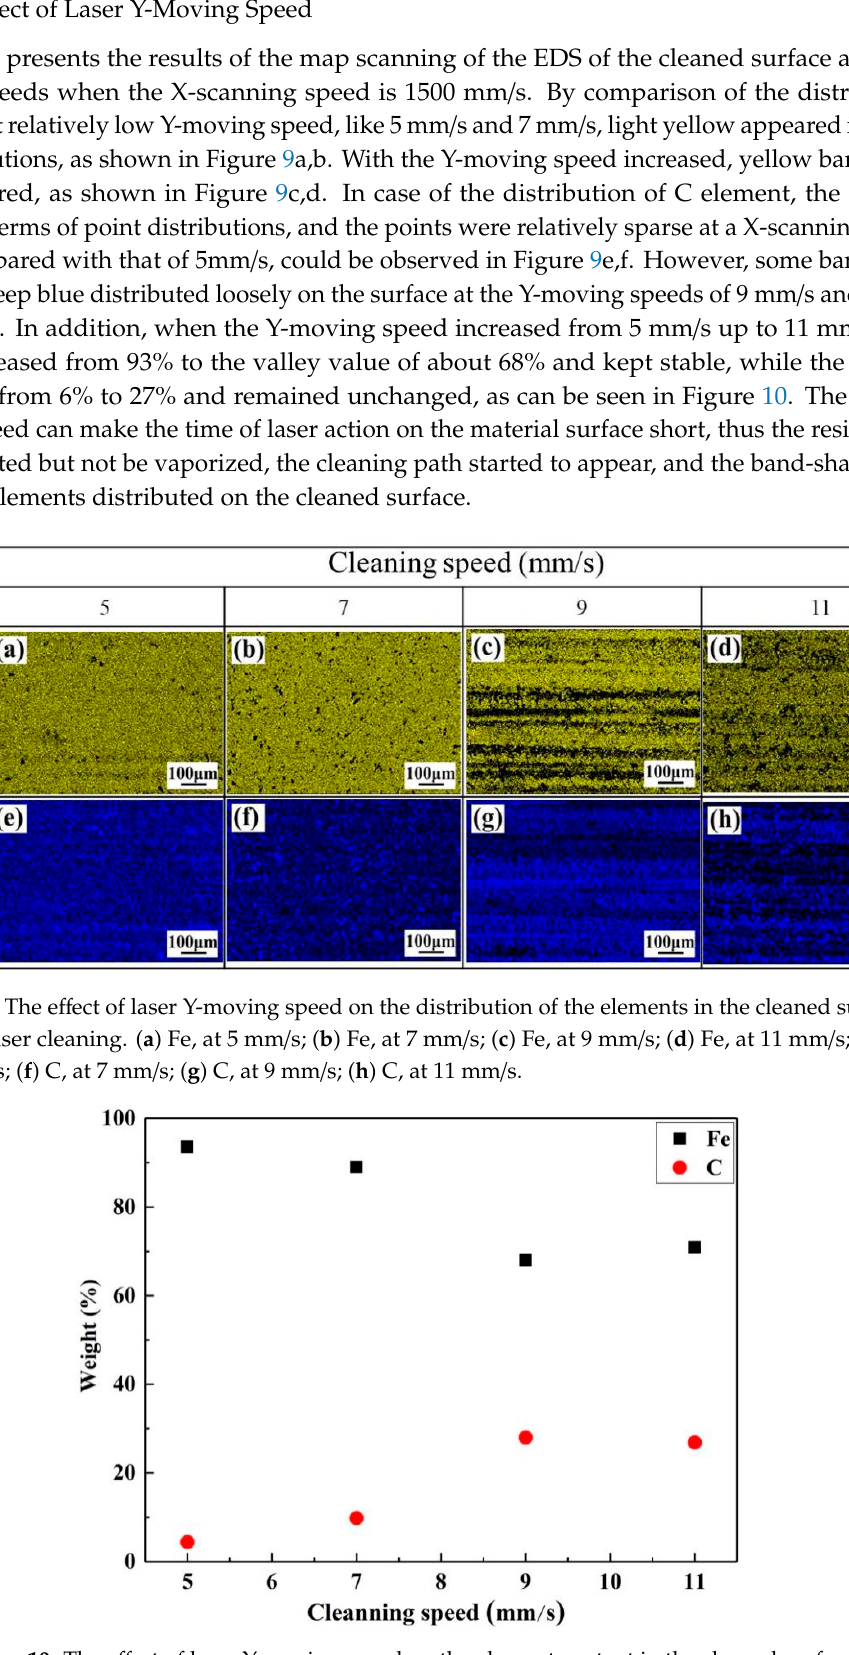
Figure 8. The effect of laser X-scanning speed on the contents of the elements of the cleaned surface.